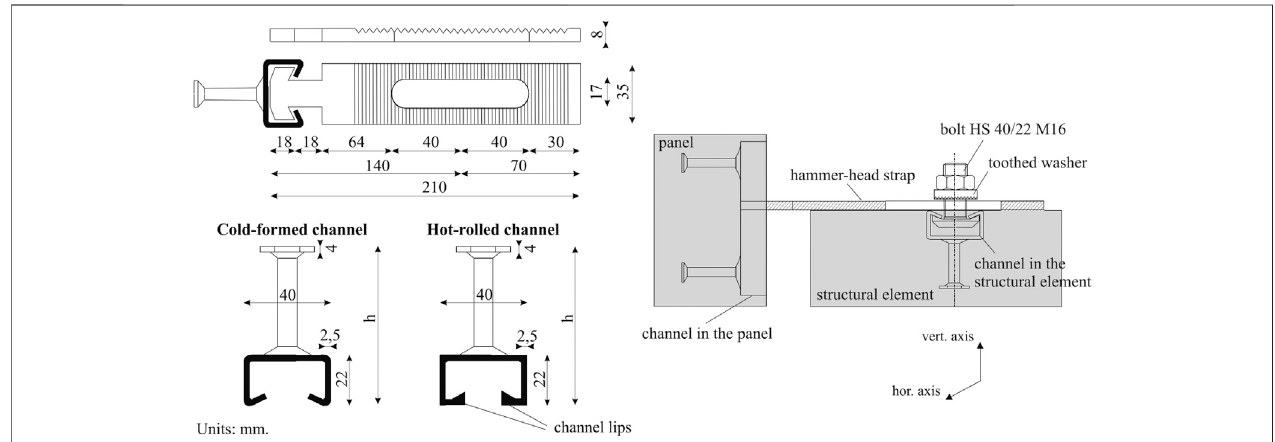
FIGURE 6 | Geometry (left) of the tested connection and (right) of the connection assembly, adopted from Zoubek et al. (2016a).